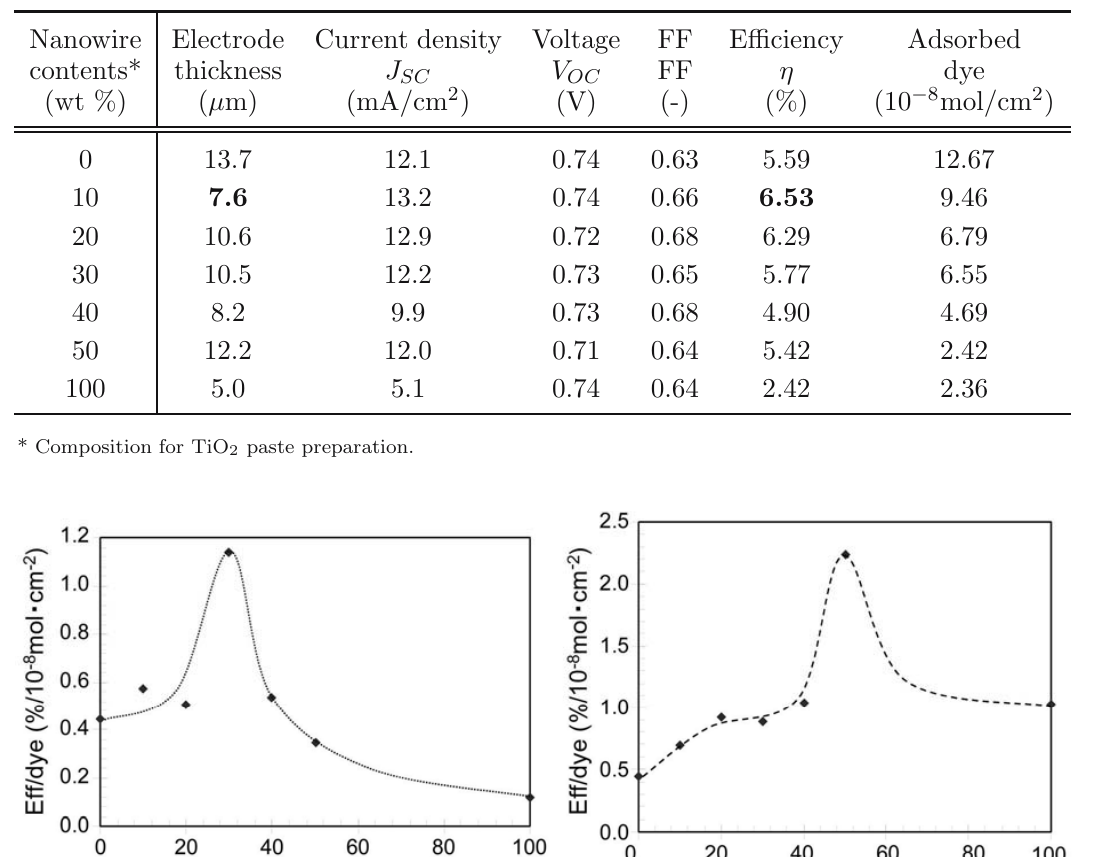
Table 2 Photovoltaic performances for various TiO 2 anatase nanowires compositions.